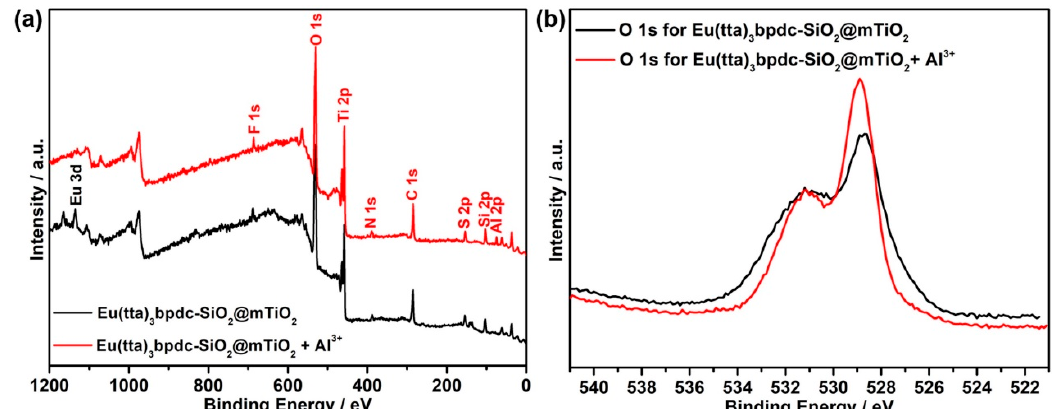
Figure 9. The concentrations of Eu III ions in the filtrate of Eu(tta) 3 bpdc-SiO 2 @mTiO 2 upon the addi- tion of different contents of Al 3+ ions.